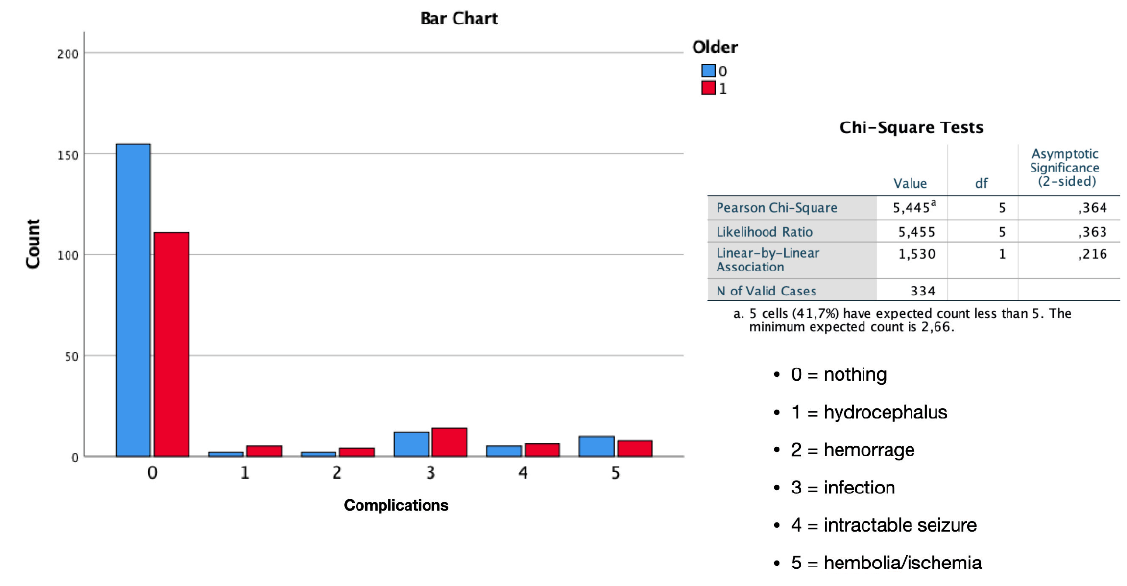
Figure 7. Analysis of complications with chi-square testing does not document the presence of an increased number of complications in the postoperative phase of young patients compared with the elderly (Figure 5), nor does it identify one type of complication as more frequent than another (Fig- Figure 7. In the analysis of complications performed with ANOVA study, there is no one type of ure 6). complication more frequent than another between the two groups.